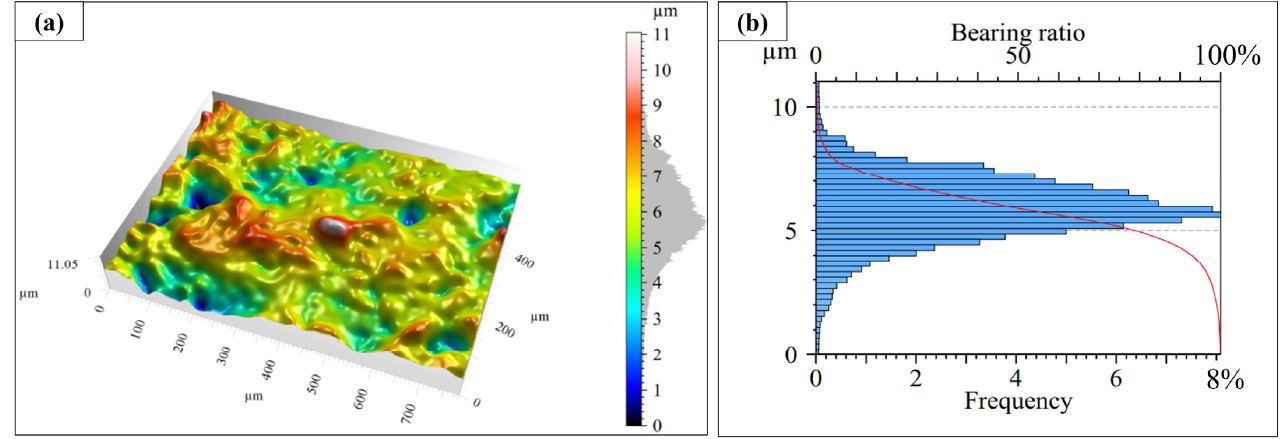
Figure 4. Profilometry map of shot-peened Cp-Ti surface ( a ) topography and ( b ) corresponding Abbott curve.